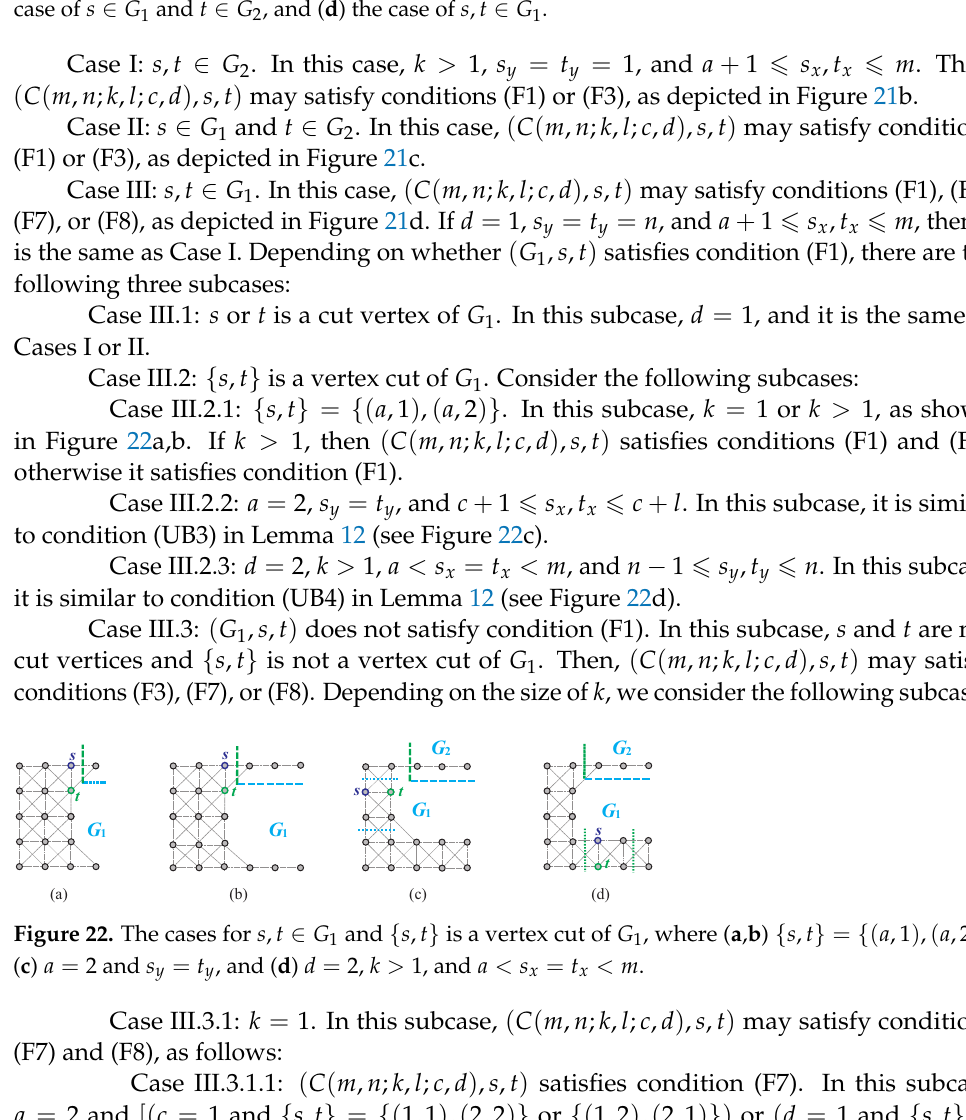
Figure 21. ( a ) The separations on C ( m , n ; k , l ; c , d ) for a (cid:62) 2 and c = 1, ( b ) the case of s , t ∈ G 2 , ( c ) the